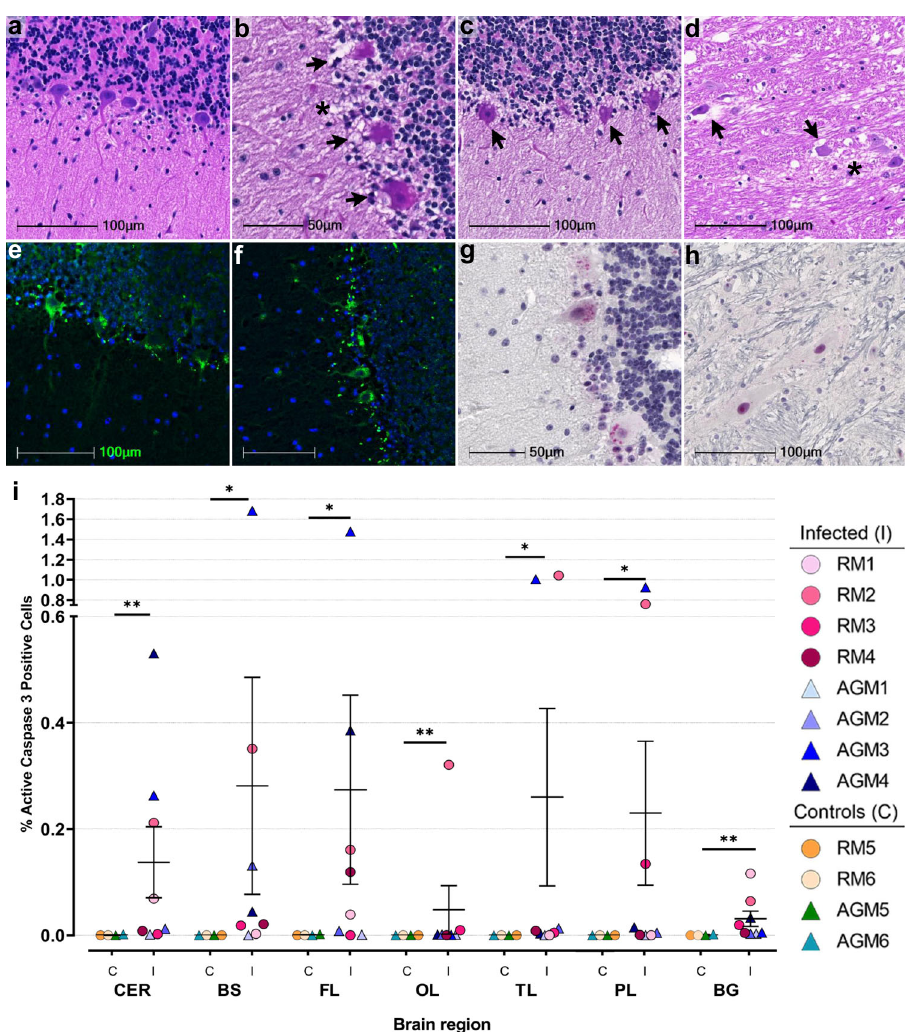
Fig. 2 Neuronal pathology and cell death in SARS-CoV-2 infection. Representative H&E images show a healthy Purkinje cell layer in the cerebellum of a non-infected control RM6 ( a ) and reveal cell death-associated neuronal changes in cerebellum of infected animals, (AGM4 b , AGM3 c ), and brainstem from AGM3 ( d ). Arrows indicate pyknotic and karyolitic Purkinje cells and cellular blebs. Asterisks denote areas of tissue necrosis/vacuolation on H&E sections ( b ) and ( d ). H&E was performed and assessed twice on all brain regions. Neuronal degeneration in cerebellum was only seen in the context of infection, visualized by positive, green FluoroJade C-stained neurons (AGM2 e , AGM1 f ). FluoroJade C staining was performed twice on the brain regions investigated. Abnormal neuronal morphology and cleaved caspase 3 positivity is demonstrated in cerebellum (AGM3 g ) and brainstem (RM2 h ). Summary data of cleaved caspase 3 positive cells strati fi ed by brain region ( i ) where n = 4 biologically independent samples/brain region in the control group and n = 8 biologically independent samples/brain region in the infected group, except OL where n = 7 infected animals. Immunohistochemical staining for cleaved caspase 3 was performed twice on all brain regions. Statistics were performed with a two-tailed Mann – Whitney U test. * p ≤ 0.05 and ** p ≤ 0.005 comparing mock-infected to infected animals. Data are expressed as mean ± SEM. p values: CER = 0.0081, BS = 0.0182, FL = 0.0323, OL = 0.0061, TL = 0.0485, PL = 0.0485, BG = 0.0040 (control vs. infected). Source data are provided as a Source Data fi le. Abbreviations: CER cerebellum,